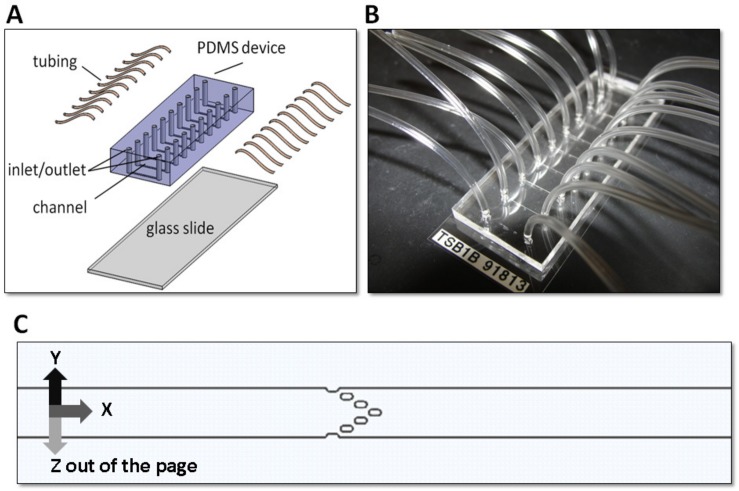
Microfluidic device design.(A) Exploded view of the device showing the main body made from PDMS containing the 1 mm diameter inlet and outlets punched for each of the 10 channels. The main body is then sealed to a 25 x 75 mm glass slide by plasma gas treatment. Tubing is inserted into each of the inlet and outlets of the device. (B) Fully assembled PDMS prototype. (C) Solid Works rendering of a channel in the device showing the central post arrangement used to trap each FNAB tissue sample. The channel is 10 mm long, 600 μm wide and 125 μm in height. Each post is 150 μm long, 75 μm wide and 125 μm in height.